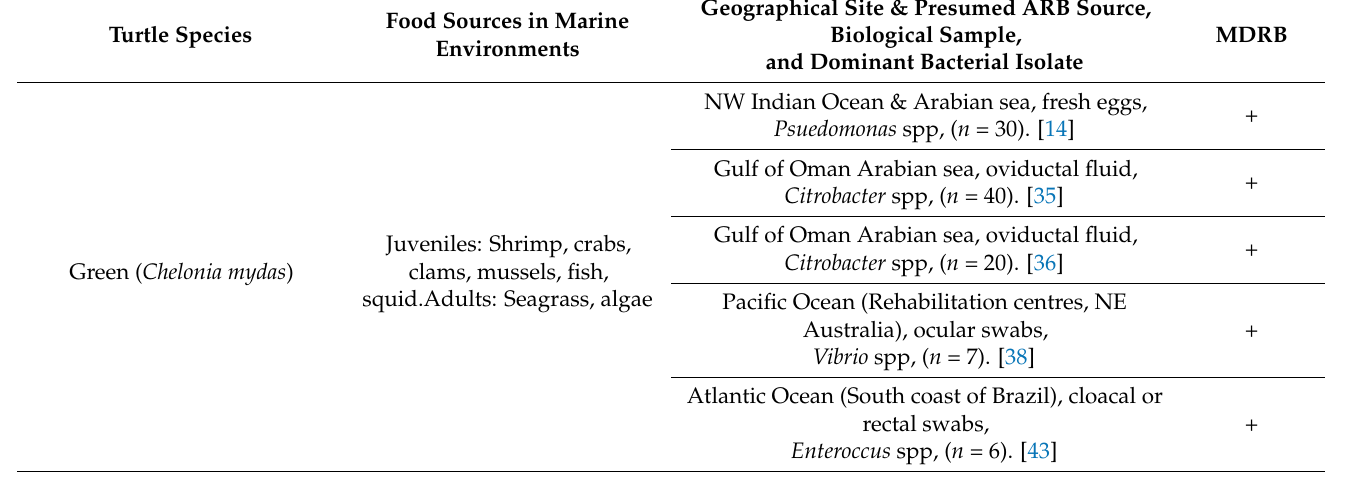
Green ( Chelonia mydas )